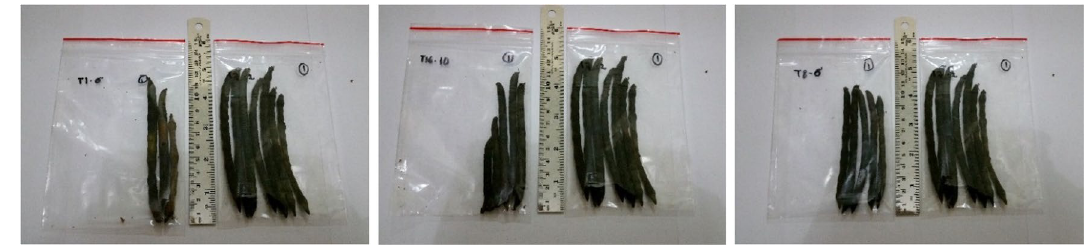
Fig. 3 Visual observations of pods of mung bean obtained at the first harvesting: T1 vs. T7, T16 vs. T7, and T8 vs. T7 (from left to